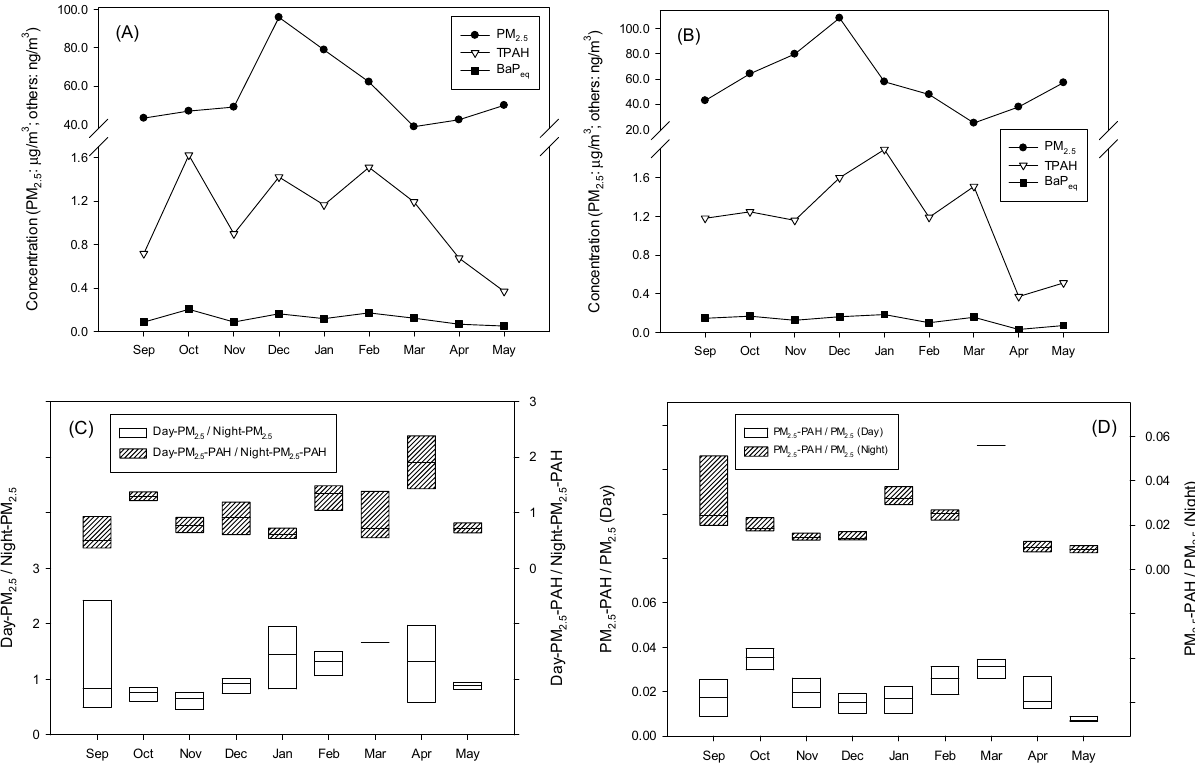
Figure 2. ( A ) Concentrations of PM 2.5 , PM 2.5 -associated PAH, and PM 2.5 -associated BaP eq during daytime and ( B ) nighttime, ( C ) daytime/nighttime PM 2.5 and PM 2.5 -associated PAH ratios, and ( D ) PM 2.5 -associated PAH/ PM 2.5 ratios during daytime and